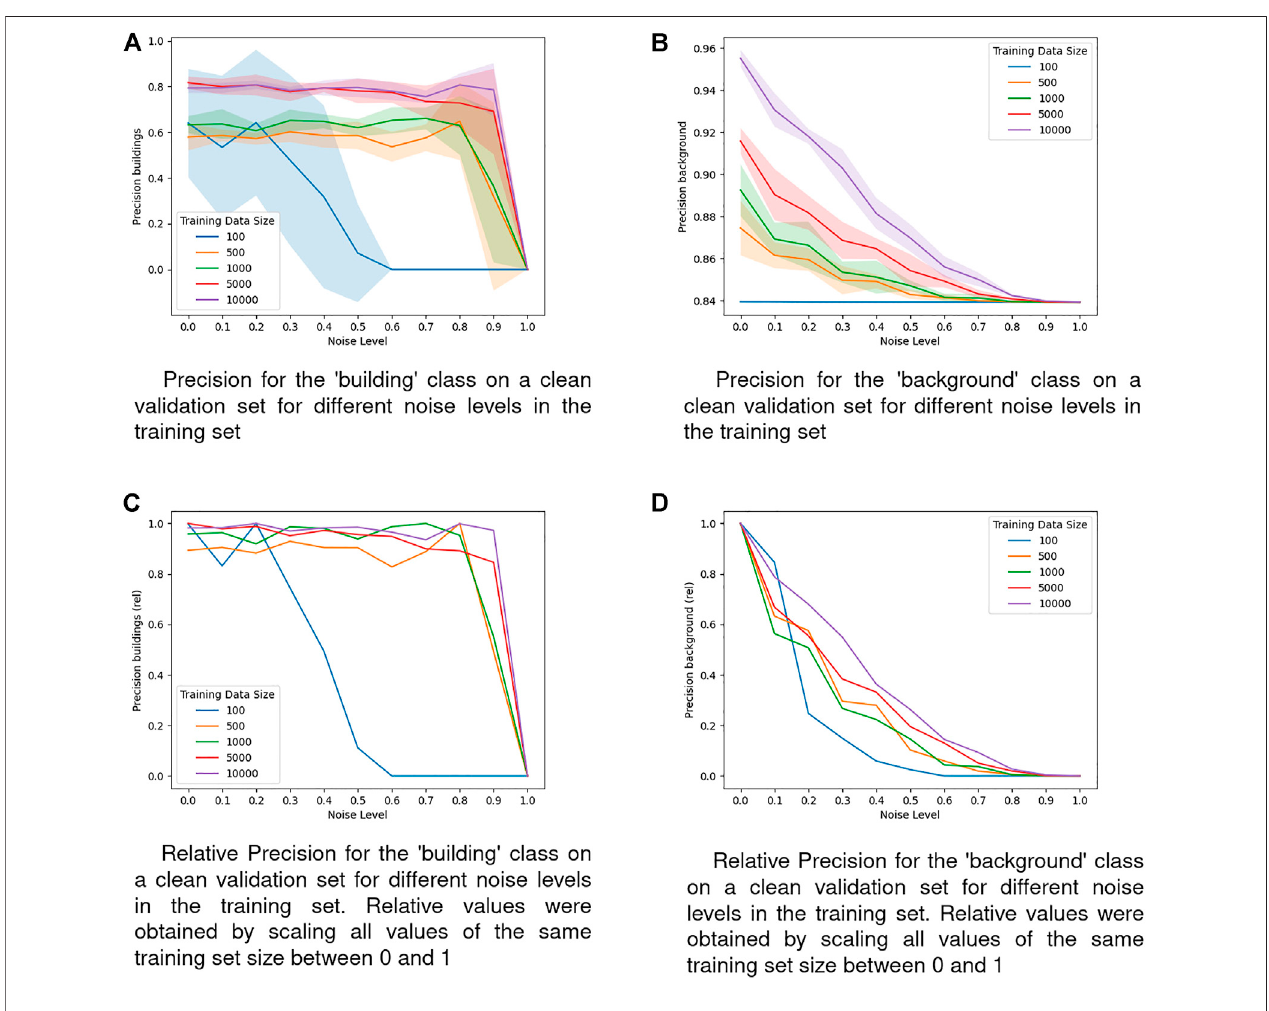
FIGURE 5 | Precision on a clean validation set for different noise levels in the training set. (A) Precision for the ‘ building ’ class on a clean validation set for different noise levels in the training set. (B) Precision for the ‘ background ’ class on a clean validation set for different noise levels in the training set. (C) Relative Precision for the ‘ building ’ class on a clean validation set for different noise levels in the training set. Relative values were obtaining by scaling all values of the same training set size between0and1. (D) RelativePrecisionforthe ‘ background ’ classonacleanvalidationsetfordifferentnoiselevelsinthetrainingset.Relativevalueswereobtaining by scaling all values of the same training set size between 0 and